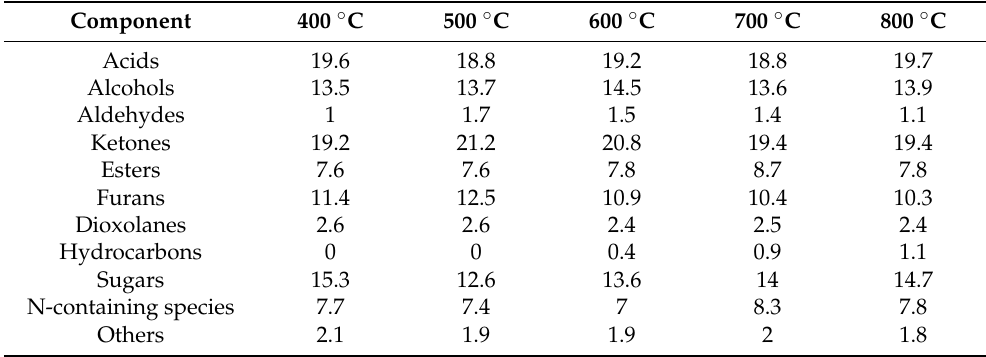
Table 2. Product distribution of the liquid phase pyrolysate made from DJW without Na 2 CO 3 at varied pyrolysis temperatures (unit: GC/MS